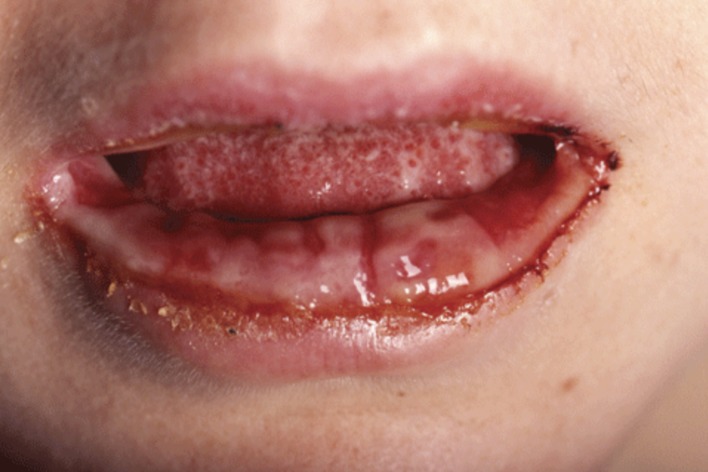
M. pneumoniae-associated mucositis (MPAM). Erosive oral lesions limited to the mucosa in this form of MPAM in a 24-year-old woman. Reprinted with permission from Meyer Sauteur et al. (2012).